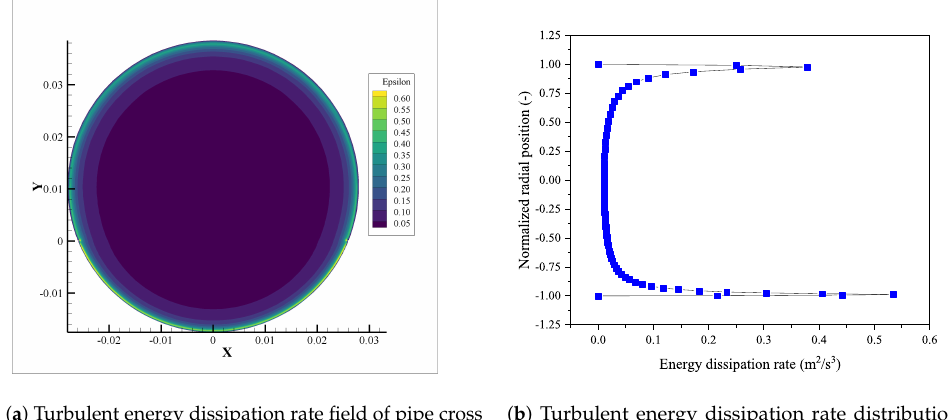
Figure 12. Calculated turbulent energy dissipation rate distribution of the pipe cross section at mixed velocity 0.43 m/s and water cut 0.25 of SST k − ω turbulence